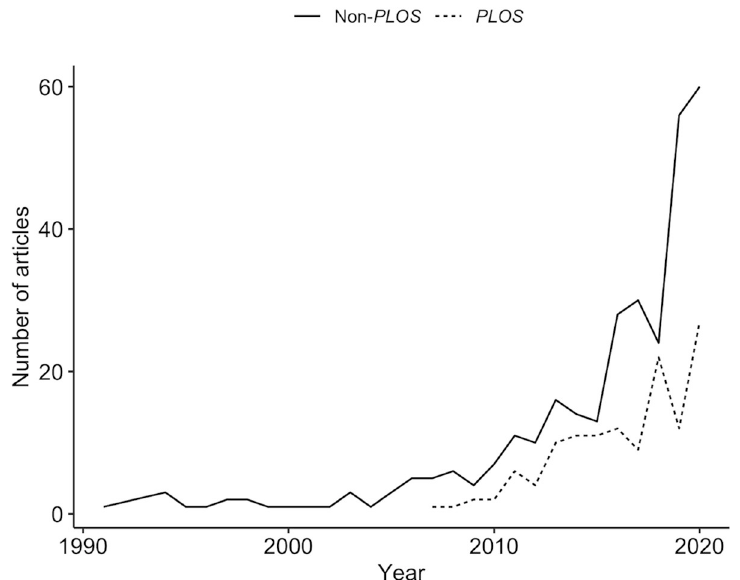
Fig 1. The number of publications (1991–2020) mentioning “web applications” (including Tableau, Shiny Apps, and WebGIS) across all PLOS publications (dashed line; PLOS) and in select publications in fields related to natural resources management (solid line; non-PLOS) has risen exponentially since approximately 2015. Data gathered from Web of Science on July 26, 2021 using the following advanced search Boolean: ‘TS = ("web app � " OR "shiny app � " OR "tableau" OR "webgis") AND (SU = ("Biodiversity & Conservation" OR "Environmental Sciences & Ecology" OR "Fisheries" OR "Forestry") OR SO = PLOS � )‘.